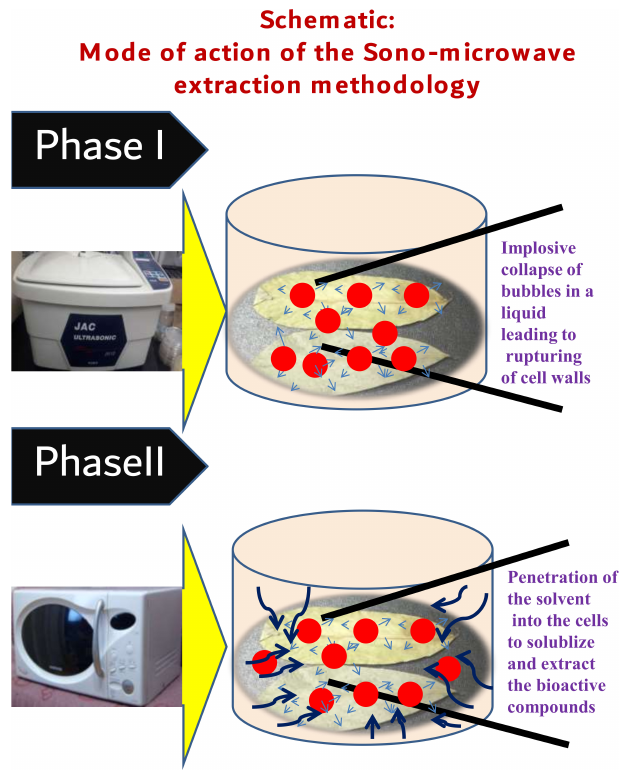
Figure 4. Schematic showing the mode of action for enhanced release of bioactive compounds by the demonstrated sono-microwave methodology for effective extraction of bioactive compounds from